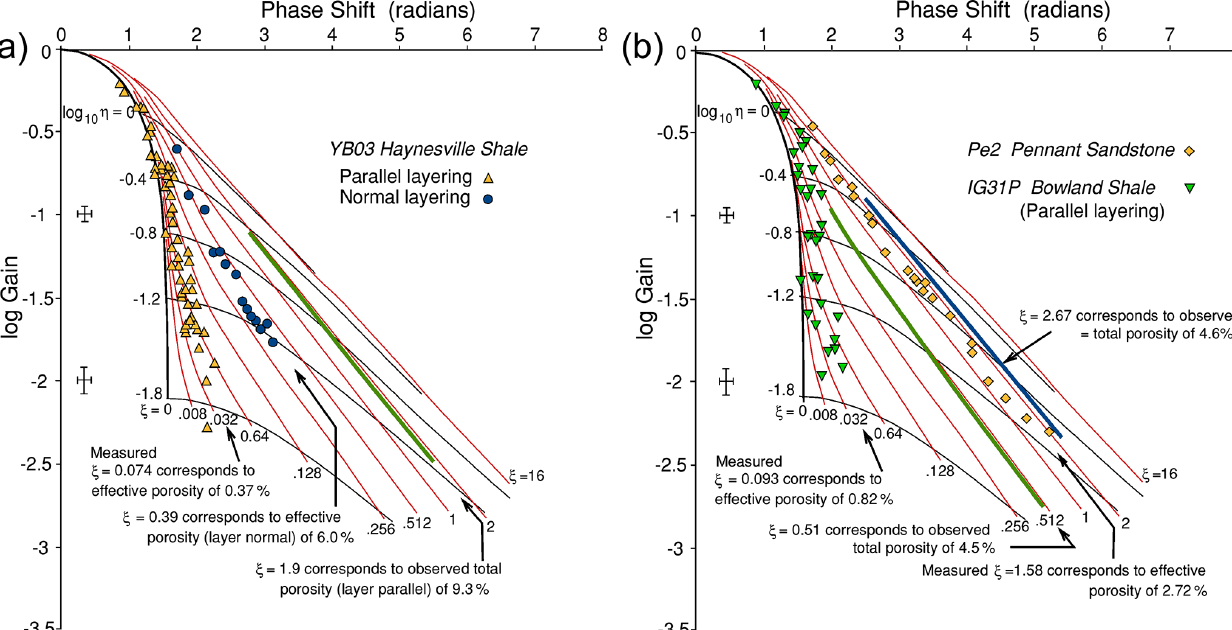
Figure 5. Log gain vs. phase angle data from oscillating pore pressure measurements on (a) Haynesville shale. ξ = 1 . 9 would correspond to total porosity 9.3% for flow in the sample parallel to layering if all porosity participates in the flow. Observed ξ = 0 . 39 normal to layering is much greater than parallel to layering ξ = 0 . 074, but both are substantially less than that corresponding to total porosity. Flow parallel to layering only “sees” or “uses” about 4% of the total pore space and normal to layering about 42% of the total pore space. (b) Bowland shale. ξ = 0 . 51 would correspond to total porosity 9.3% for flow in the sample parallel to layering if all porosity participates in the flow. Observed ξ = 0 . 093 for flow parallel to the layering corresponds to a conductive porosity (0.82%) much less than total porosity. In contrast, data for Pennant sandstone show observed ξ = 1 . 58 to be closer to that ξ = 2 . 67, which corresponds to the total porosity of the rock.